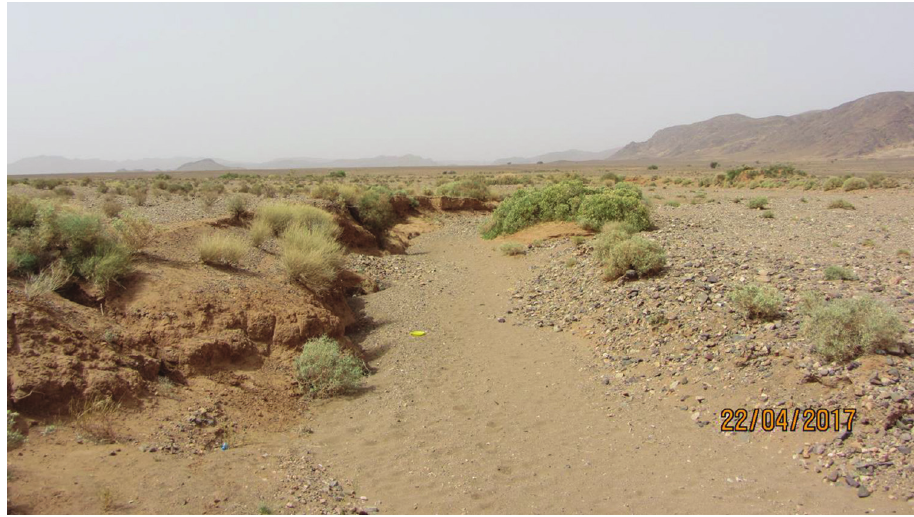
Figure 7. Habitat of the type locality of Diaphorocera neglecta sp.